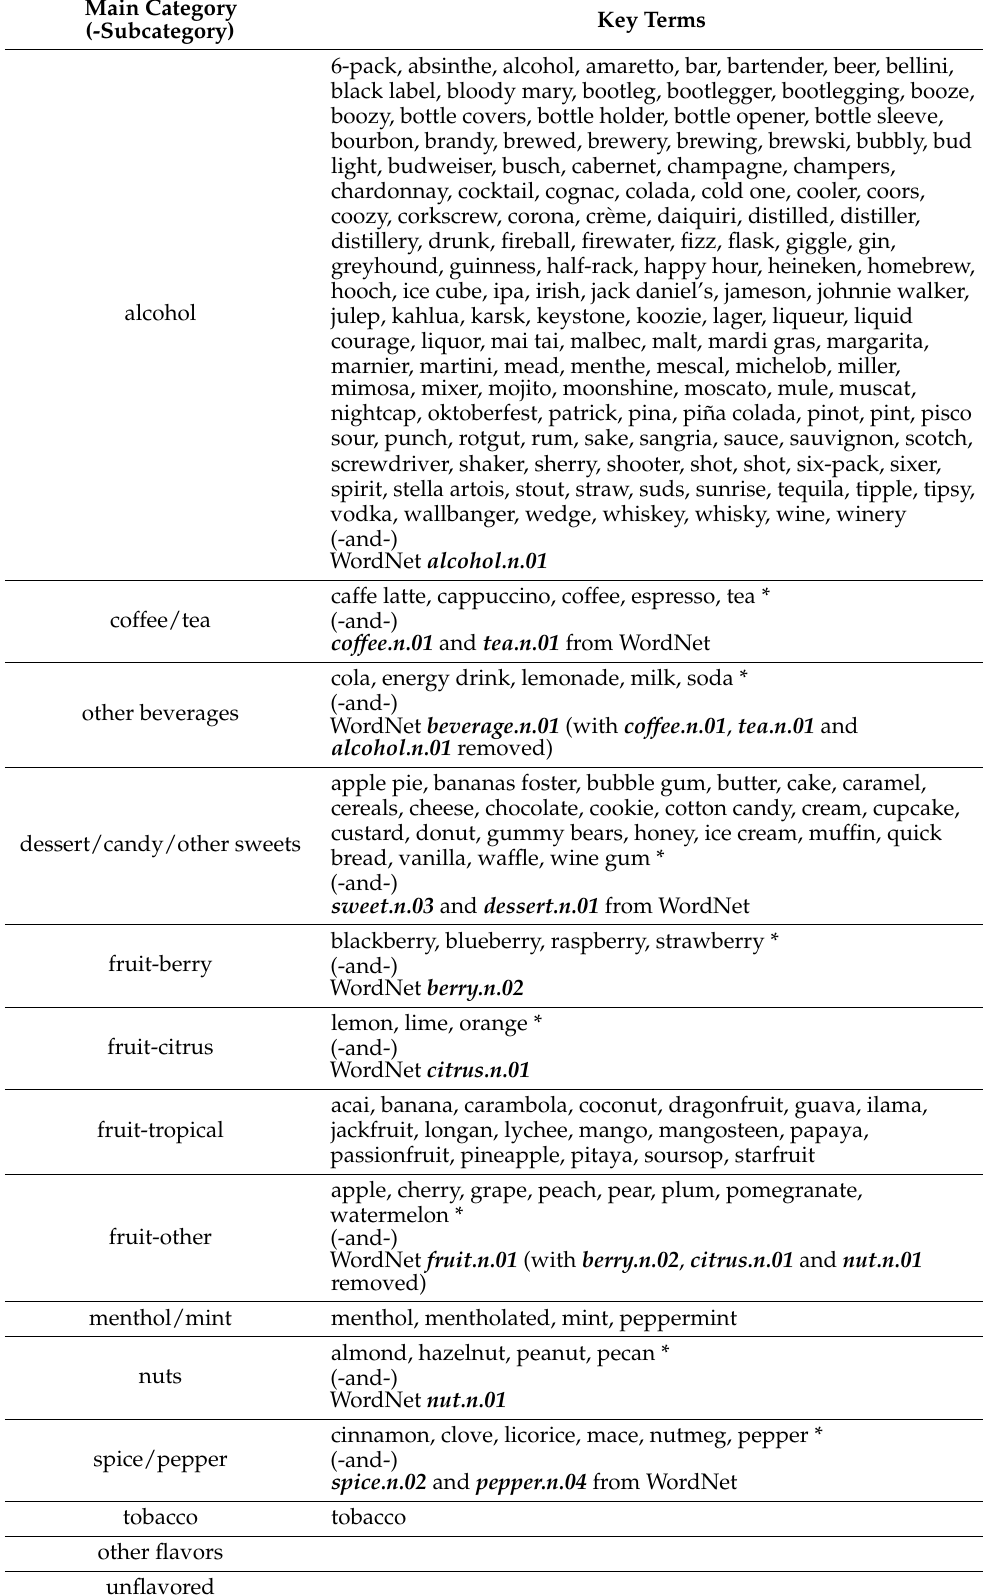
Table A1. E-liquid Flavors: Main Categories, Subcategories, and Key Terms. Main Category